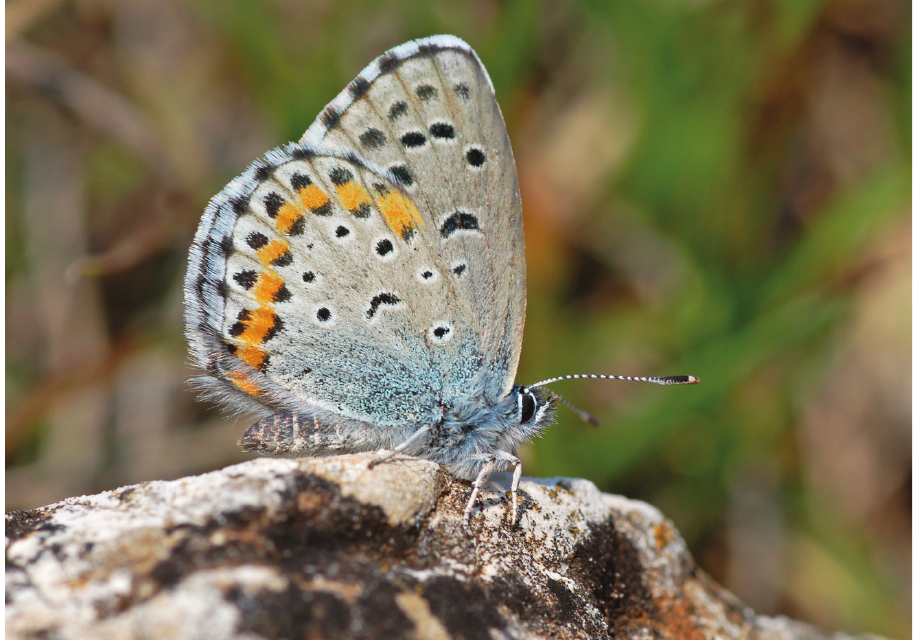
Pseudophilotes bavius . Photo Albert Vliegenthart.